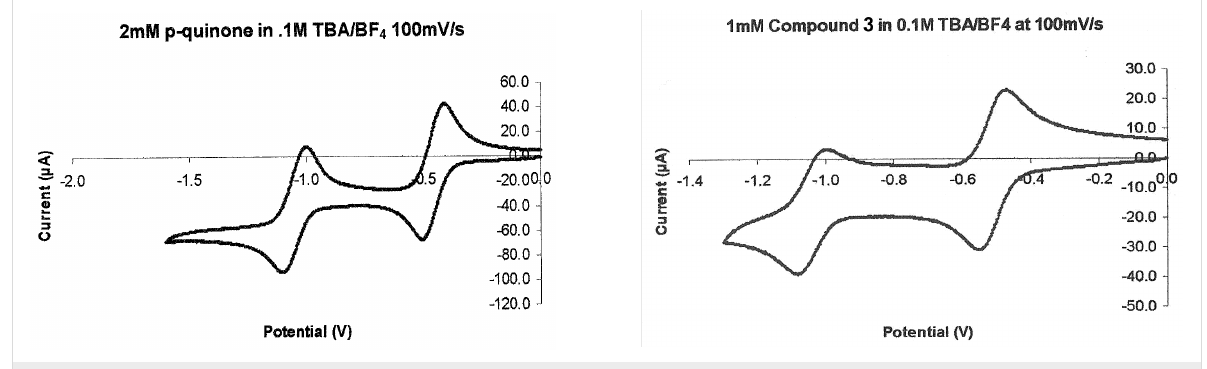
Figure 16: CV for p-benzoquinone and quinone 3 .